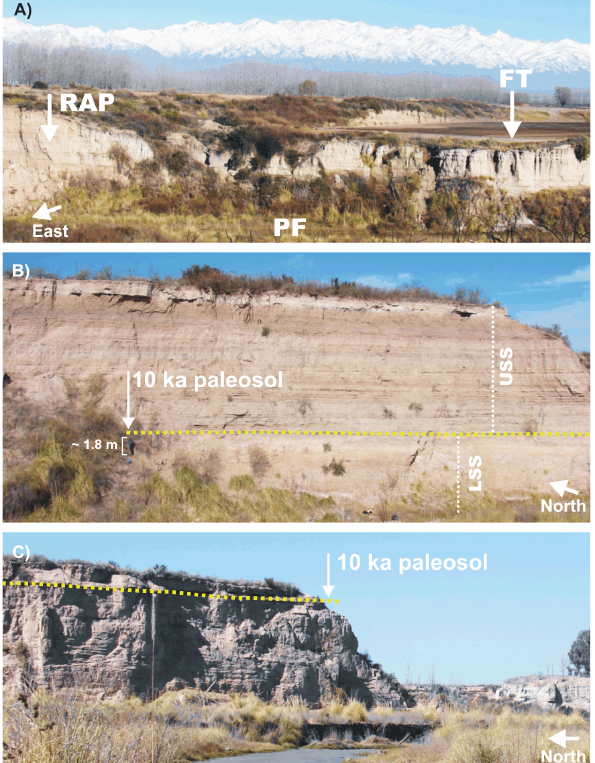
Fig. 2. Late Pleistocene–Holocene alluvial sequence at Arroyo La Estacada. (A) View of the three geomorphological units differen- tiated at the arroyo valley: regional aggradational plain (RAP), fill terrace (FT) and present floodplain (PF) (Zárate, 2002; Zárate and Mehl, 2008). (B) Puente El Zampal study site: RAP unit at the cut bank of Arroyo Anchayuyo; lower and upper stratigraphic sections (LSS, USS) are shown. (C) RAP at Finca Gatica study site, Arroyo La